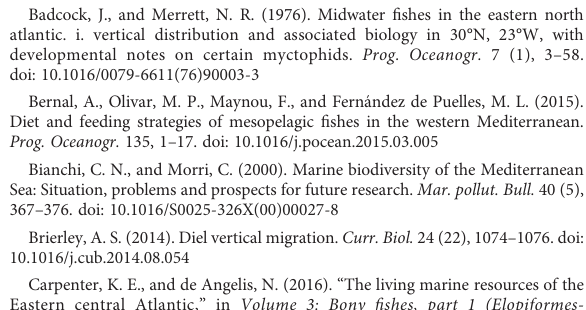
SUPPLEMENTARY FIGURE 4 Day andnight verticaldistribution of all fi shcollected through the fi rst 700 m of the water column a) numbers b)